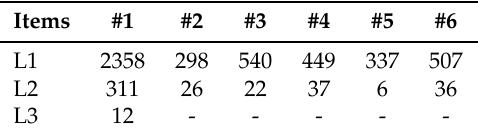
Table 1. The number of regions in six cities at three different spatial levels. To obtain the L1 level city segmentation, we use the freeways, city expressways, and the urban arterial roads to partition the city. As for L2 level city segmentation, we remove the urban arterial roads. L3 level city segmentations equal to the administrate units.